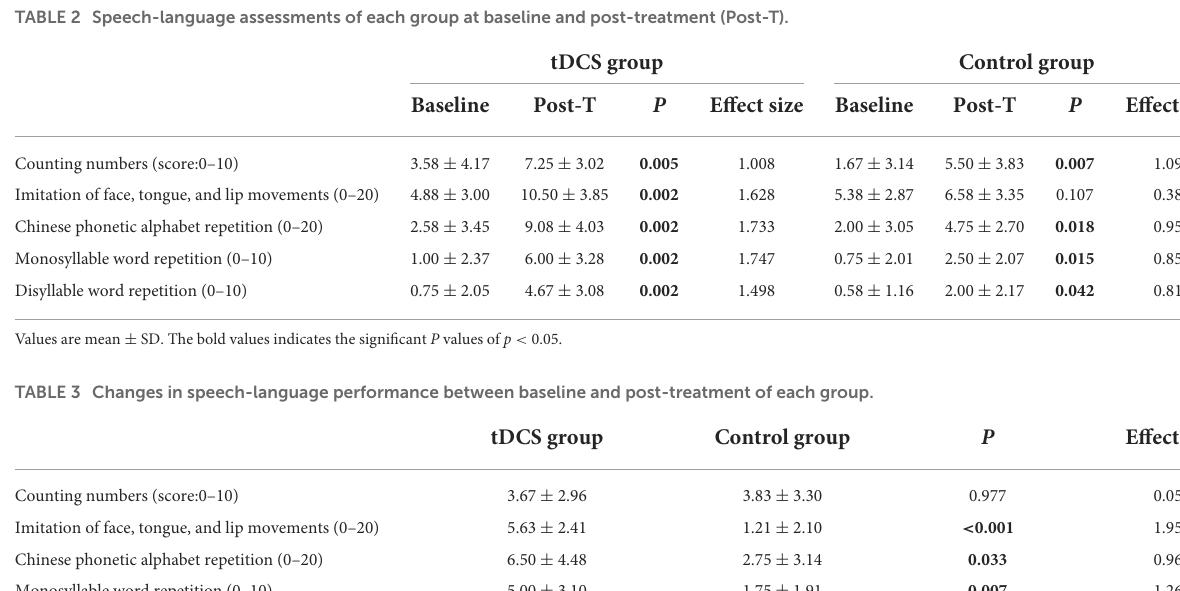
TABLE 2 Speech-language assessments of each group at baseline and post-treatment (Post-T).